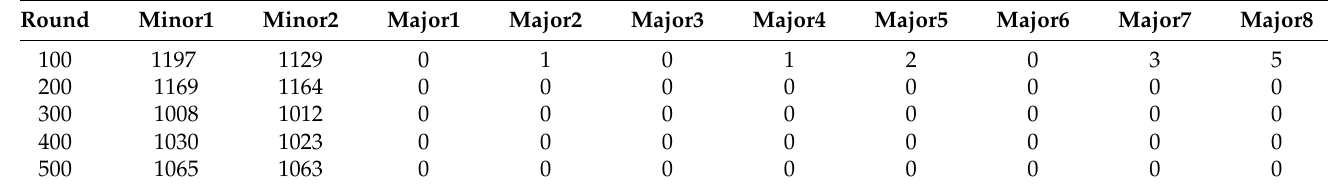
Table 6. FedAvg forgettable example counts in each client when non-IID (2-to-8).